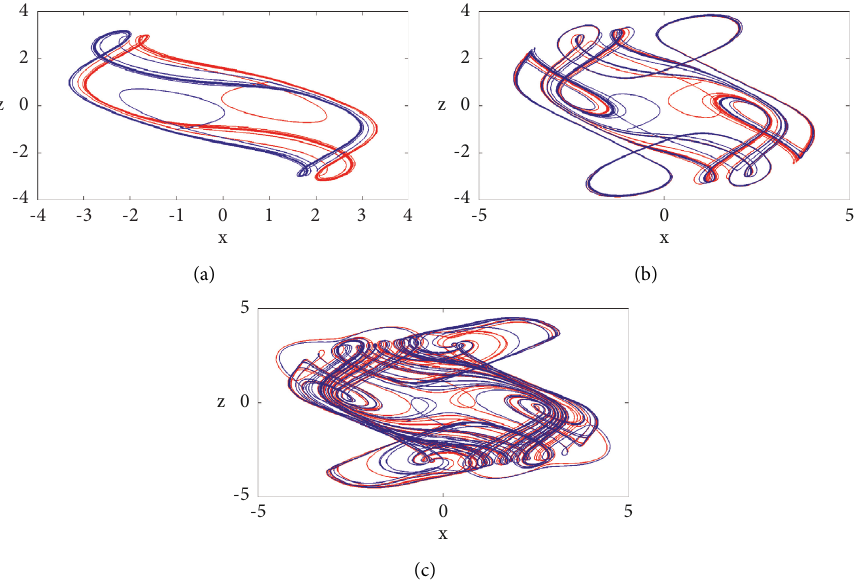
Figure 14: Phase portraits of coexisting symmetric attractors according to the system parameters a � 1 and b � − 9, the IC ( x for the red line, and the IC ( x ,q ,q ] � [ 0 . 80 , 1 , 1 ] , and (c) [ q (b) [ q 1 2 3